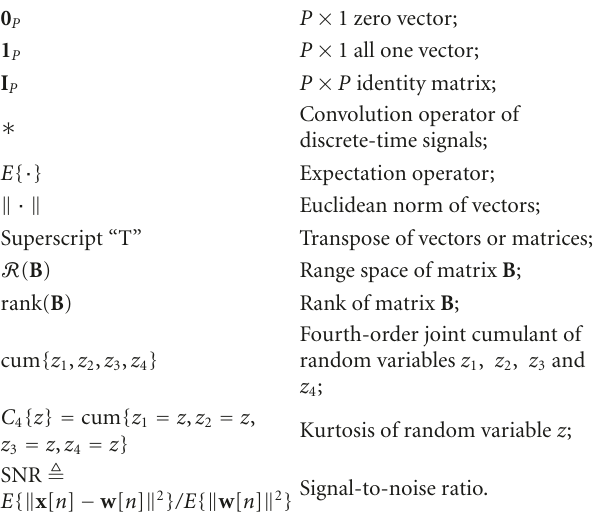
Table 1: Mathematical